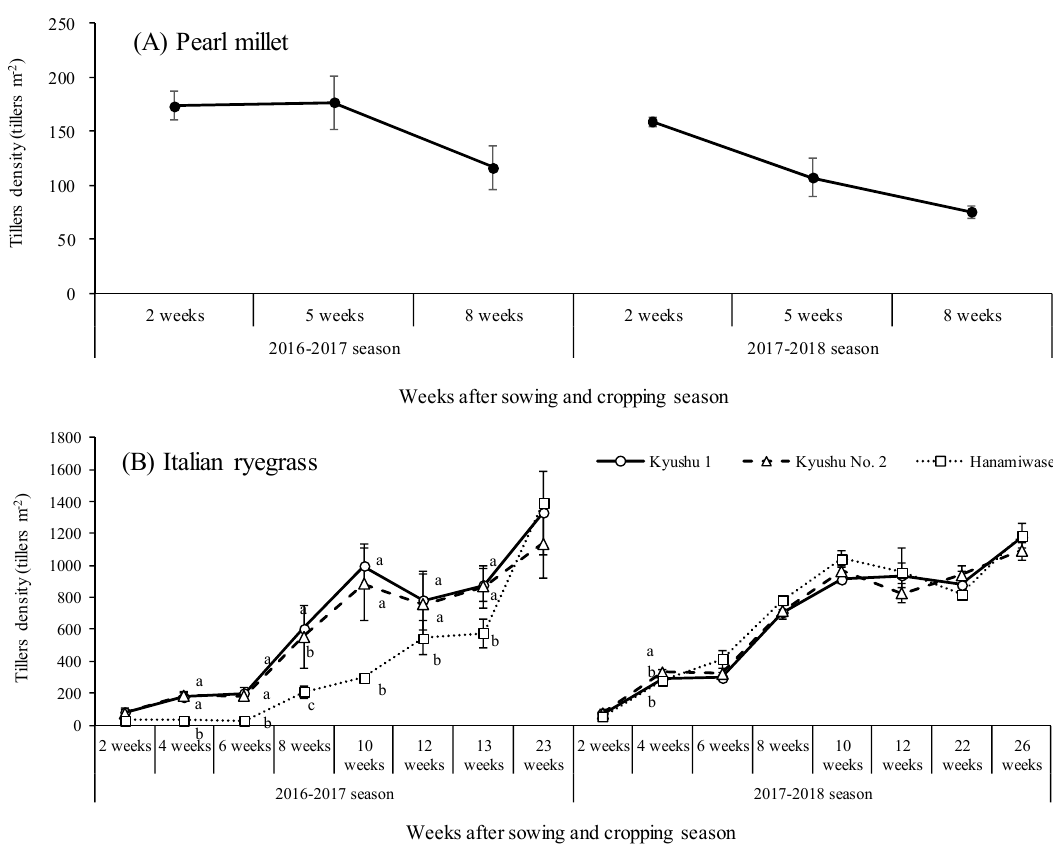
Figure 3. Changes in tiller density in pearl millet ( A ) and twice-cut Italian ryegrass ( B ) in two cropping seasons. Values show mean ± standard error ( n = 3). a–c p < 0.05 among cultivars in the same cropping season and date.